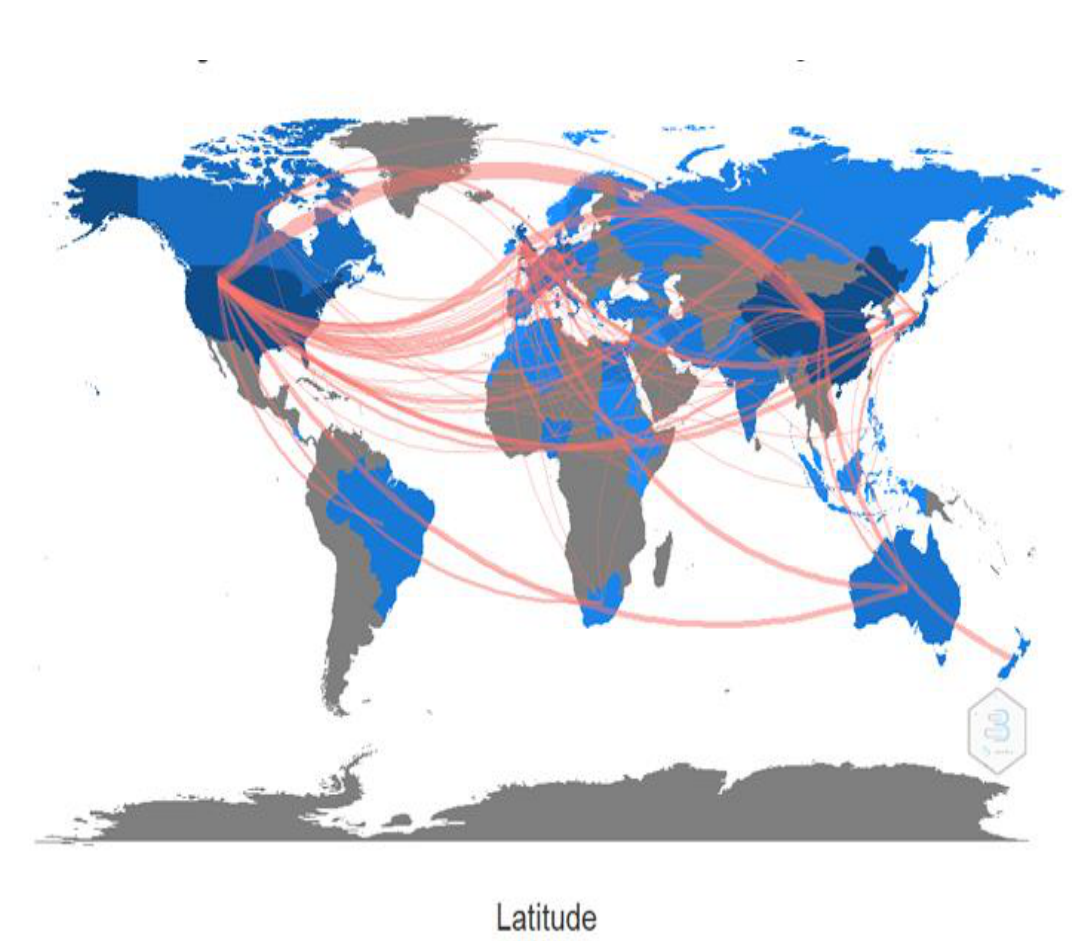
Figure 6. The country-collaboration map among countries and international collaboration in the ALV research.